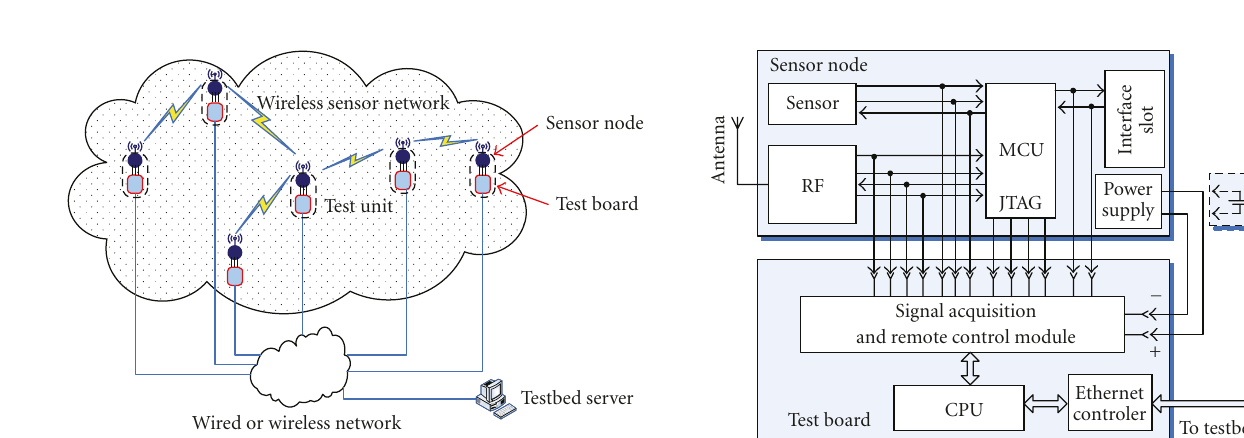
Figure 7: Block diagram of HINT test unit.